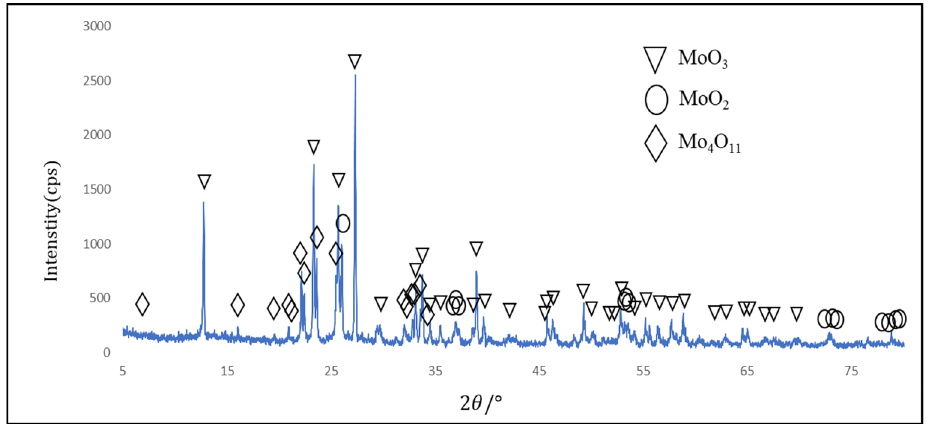
Figure 6. XRD analysis of (NH 4 ) 4 Mo 5 O 17 after heating at 575 °C for 60 min in Ar atmosphere.